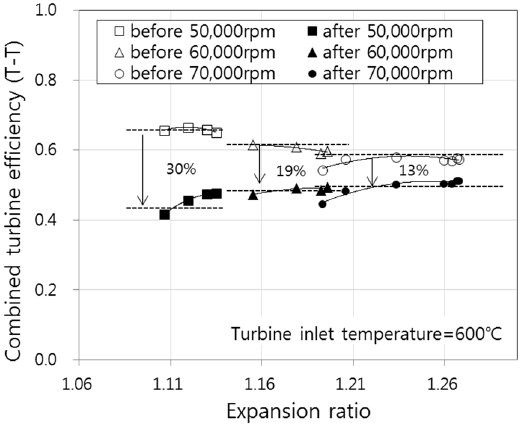
Figure 10. Compressor of corrected combined turbine efficiency by rotational speed at the turbine inlet temperature of 600 °C.